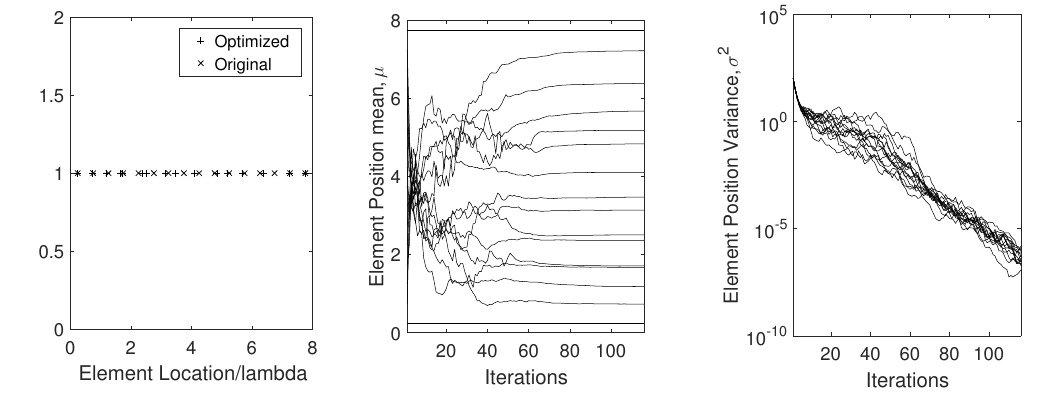
Figure 8. The array optimization